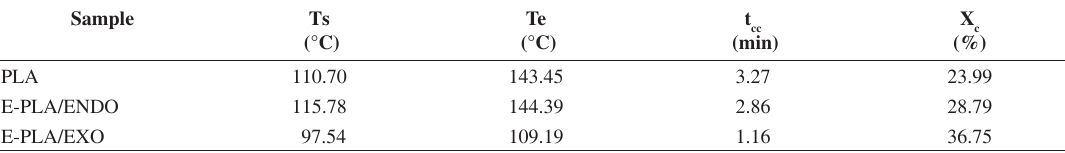
) and crystallinity index (X cc